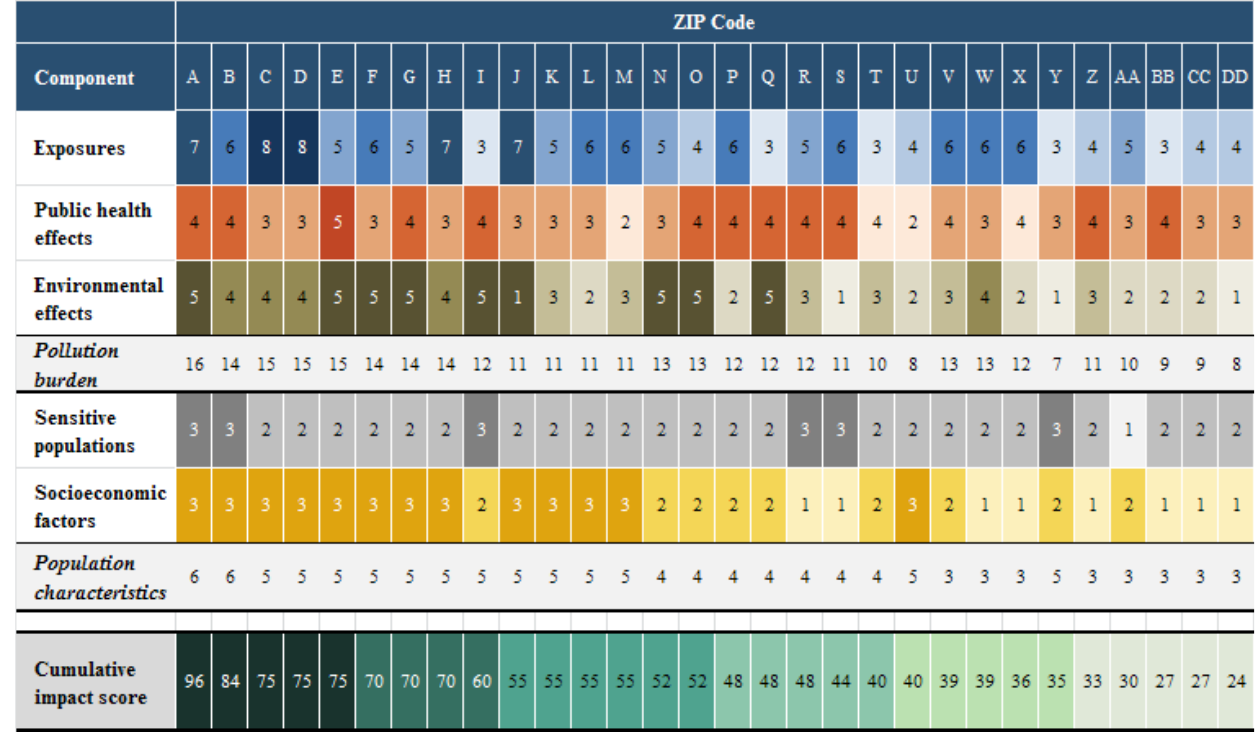
Figure 3. Component and cumulative impact scores for thirty California ZIP